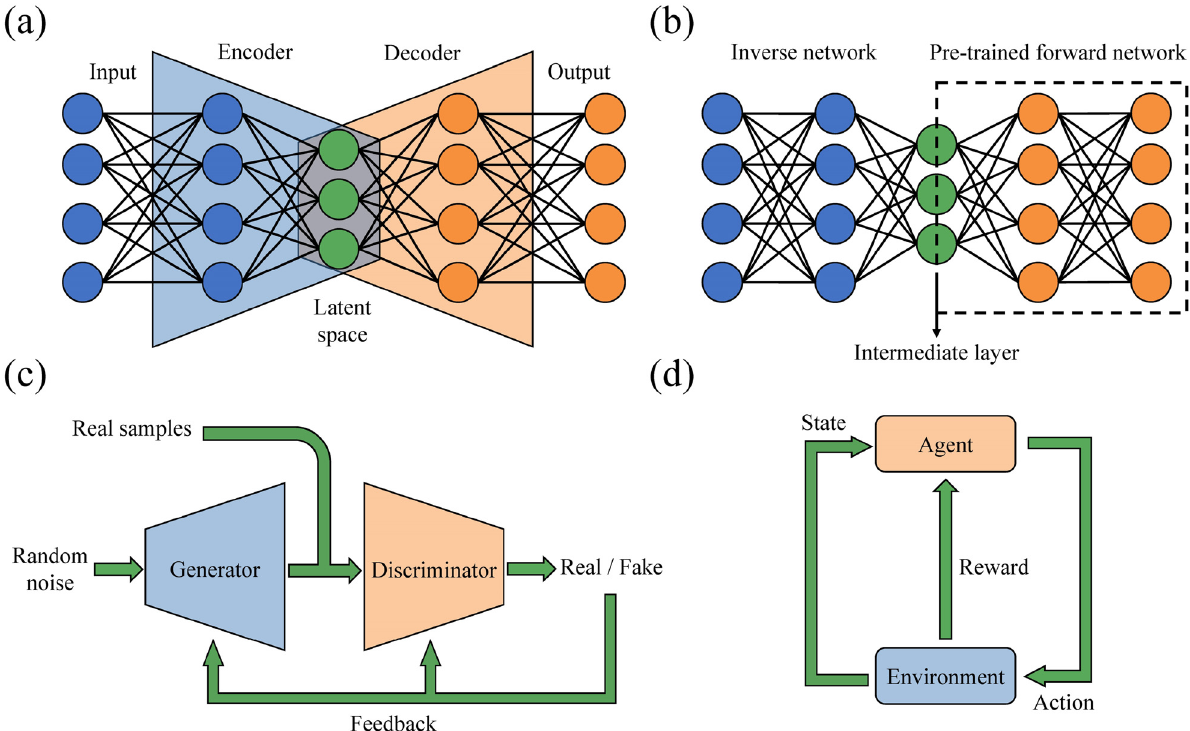
Figure 3: Schematic diagrams of unsupervised learning and reinforcement learning. (a) AE. The encoder maps the high-dimensional data to the low-dimensional latent space, and the decoder can reconstruct the high- dimensional data according to the features. (b) TNNs. An inverse design network connected to a forward modeling network. The forward modeling network is trained in advance, then train the whole network under the condition of freezing the weights in the forward modeling network. The design results are output from the intermediate layer. (c) Generative adversarial networks. The generator and discriminator compete with each other, so that the generator has the ability to output close to the real samples. (d) Reinforcement learning. The agents execute appropriate actions in the environment to obtain the maximum cumulative